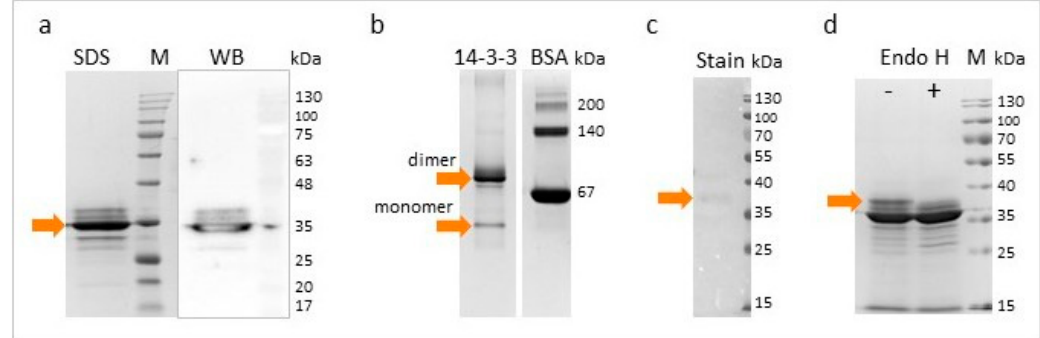
Figure 2. Analysis of rTb14-3-3 protein produced in P. pastoris culture. ( a ) Purified recombinant protein (7 μ g/lane) visualized with SDS-PAGE and Anti-His Western blot. M-marker ( b ) Native PAGE of rTb14-3-3 (6 μ g/lane) and bovine serum albumin (BSA), used as a molecular standard (molecular weight of BSA monomer and dimer is indicated). The predicted rTb14-3-3 monomer and dimer forms are marked with arrows. ( c ) Colorimetric detection of glycoproteins. Protein samples (6 μ g/lane) were separated on SDS-PAGE, and transferred to the nitrocellulose membrane. Slight coloration, corresponding to the top band of rTb14-3-3, is marked with an arrow. ( d ) SDS-PAGE after deglycosylation of rTb14-3-3 with Endo H. Protein samples (8 μ g/lane) were incubated with Endo H enzyme (+), or without Endo H ( − ), in denaturing conditions. The top band, which was no longer present after the enzymatic digestion, is marked with an arrow.